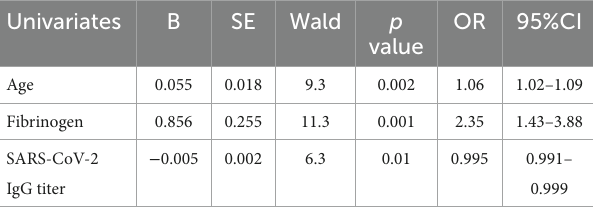
TABLE 2 Independent predictors for the onset of Delta variant-induced pneumonia on admission. Univariates